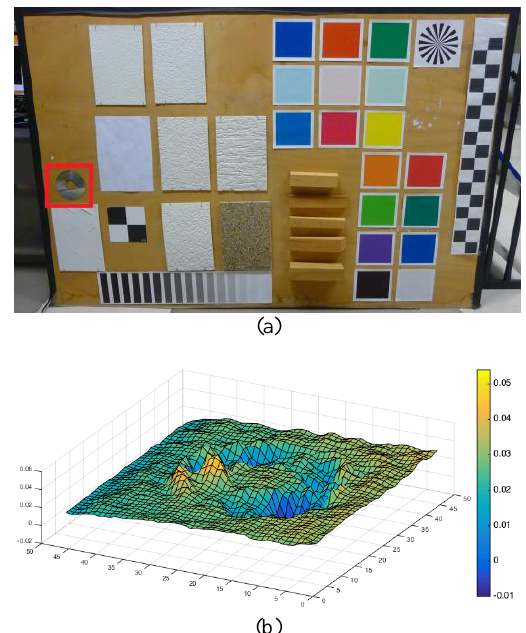
Figure 6. (a) Samples characterized by different albedos and roughness; (b) zoom on the red frame: depth variations (m)